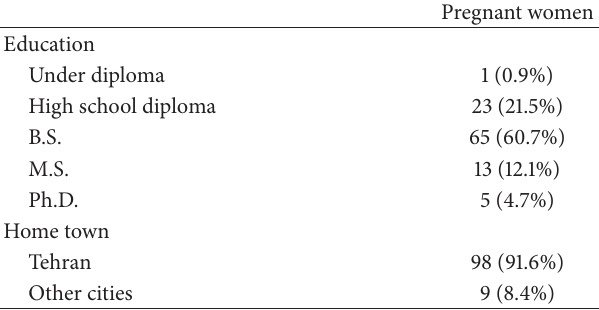
Table 1: Demographic information of